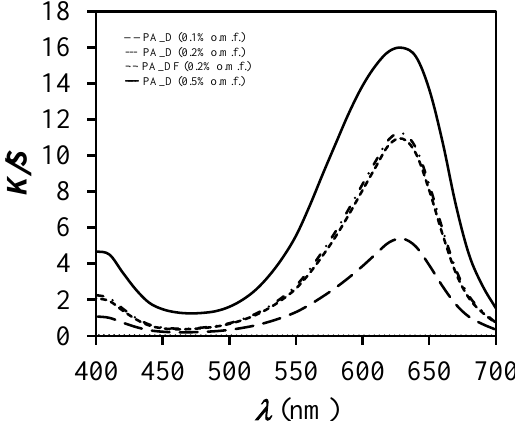
Figure 5. K / S values ( b *) vs. wavelength ( λ ) for unfinished (PA_D) and finished (PA_DF) dyed samples Figure 5. K/S values (b) vs. wavelength ( λ ) for unfinished (PA_D) and finished (PA_DF) dyed samples of di ff erent dye concentrations of different dye concentrations